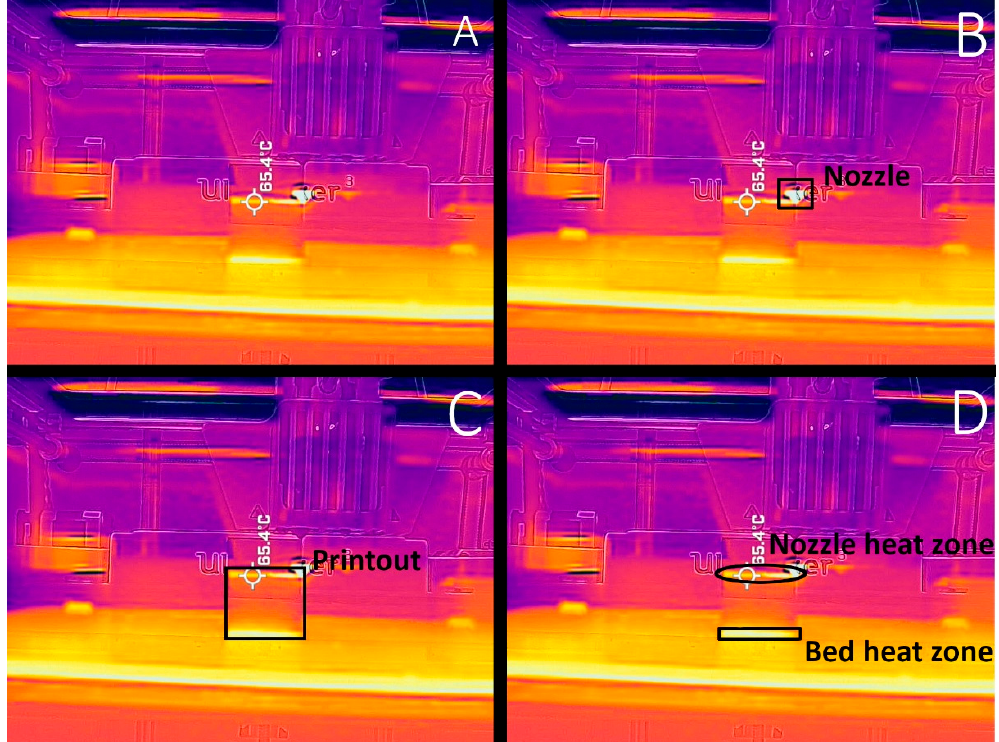
Figure 13. Thermal images obtained during printing: ( A ) printing chamber; ( B ) indicated heat sources—nozzle and bed; ( C ) marked print; ( D ) temperature layout on the printout. Temperature indicated in FLIR software [30].